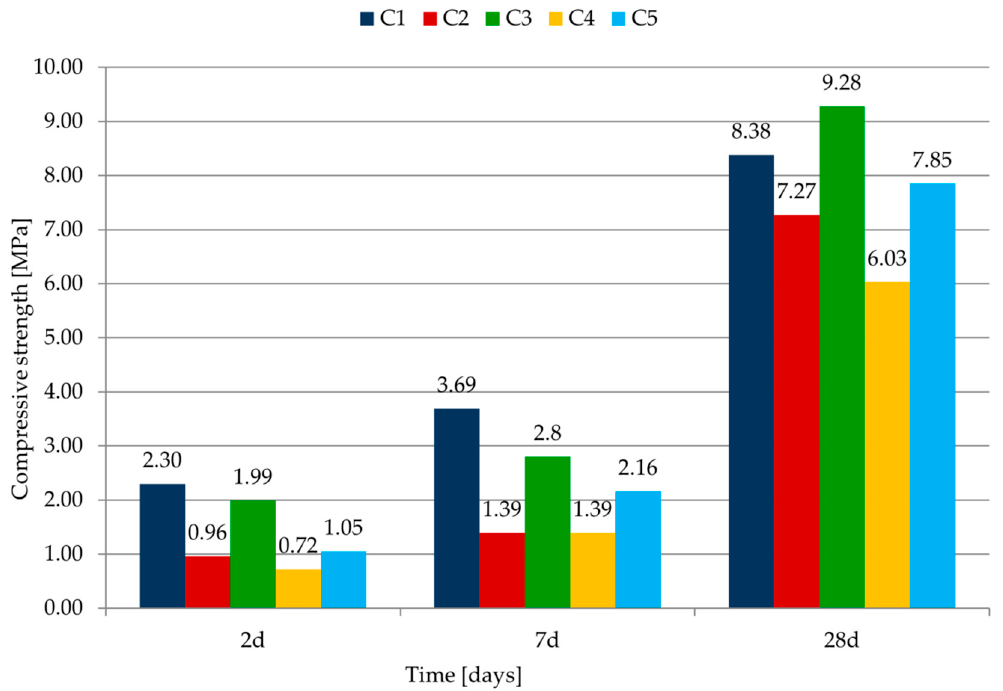
Figure 6. Change of the compressive strength after different curing times.